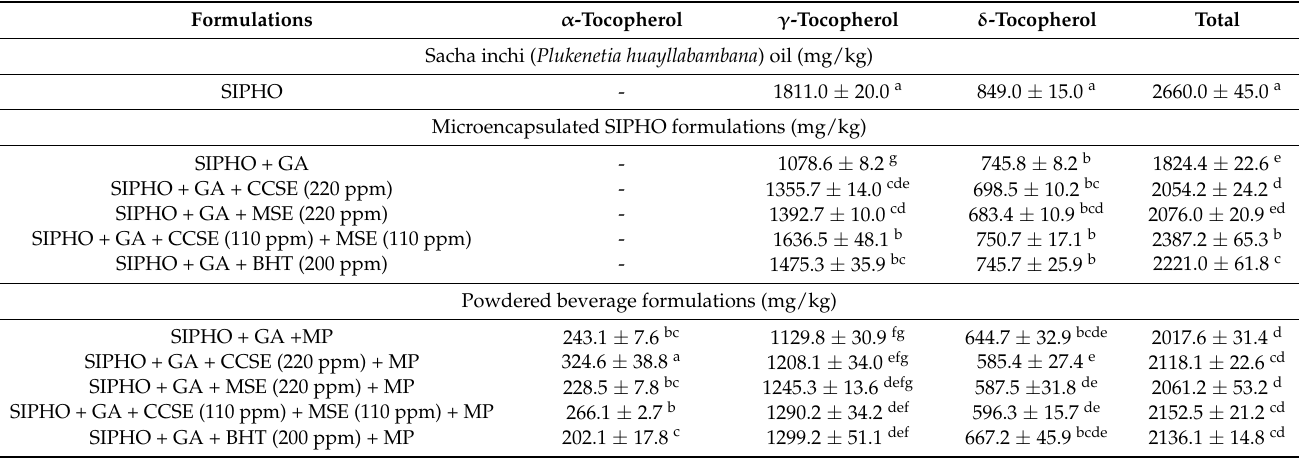
Table 5. Total phenolic content (TPC) ( µ g GAE/g powder), surface phenolic content